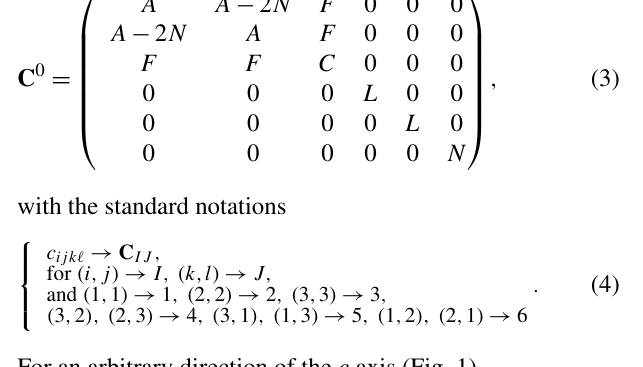
Figure 1. Spherical angles ( ϕ , θ ) used for the orientation of the c axis, ( ˆ c is an unitary